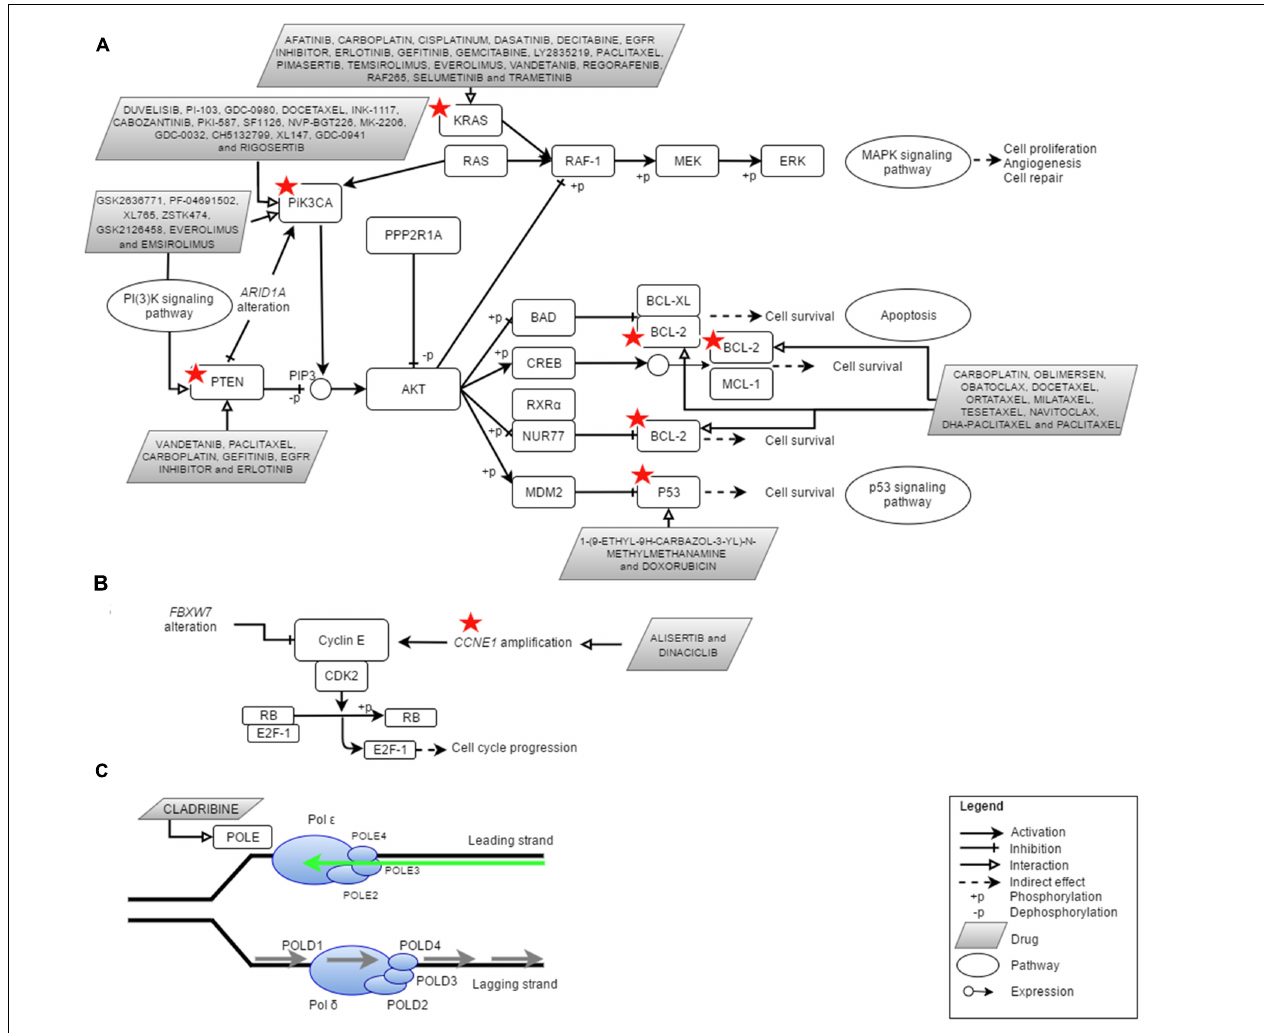
FIGURE 1 | Cellular pathways currently being targeted in the treatment of endometrial cancer (EC) and the potential actionable genes in EC identified via Next Generation Sequencing (NGS). Red star depicted genes with clinically cancer-relevant drug interactions as defined by DGIdb (Wagner et al., 2016). (A) PI(3)K, MAPK, p53 and apoptosis pathway involving PIK3CA , PTEN , PPP2R1A , KRAS , P53 , and BCL2 , (B) cell cycle pathway involving FBXW7 and CCNE1 as well as (C) DNA replication pathway in eukaryote which involves POLE (DNA polymerase ε ). Figures were adapted from Kanehisa et al. (2016) and Seshagiri (2013). Adapted by permission from Macmillan Publishers Ltd: [NATURE GENETICS] (Seshagiri), copyright